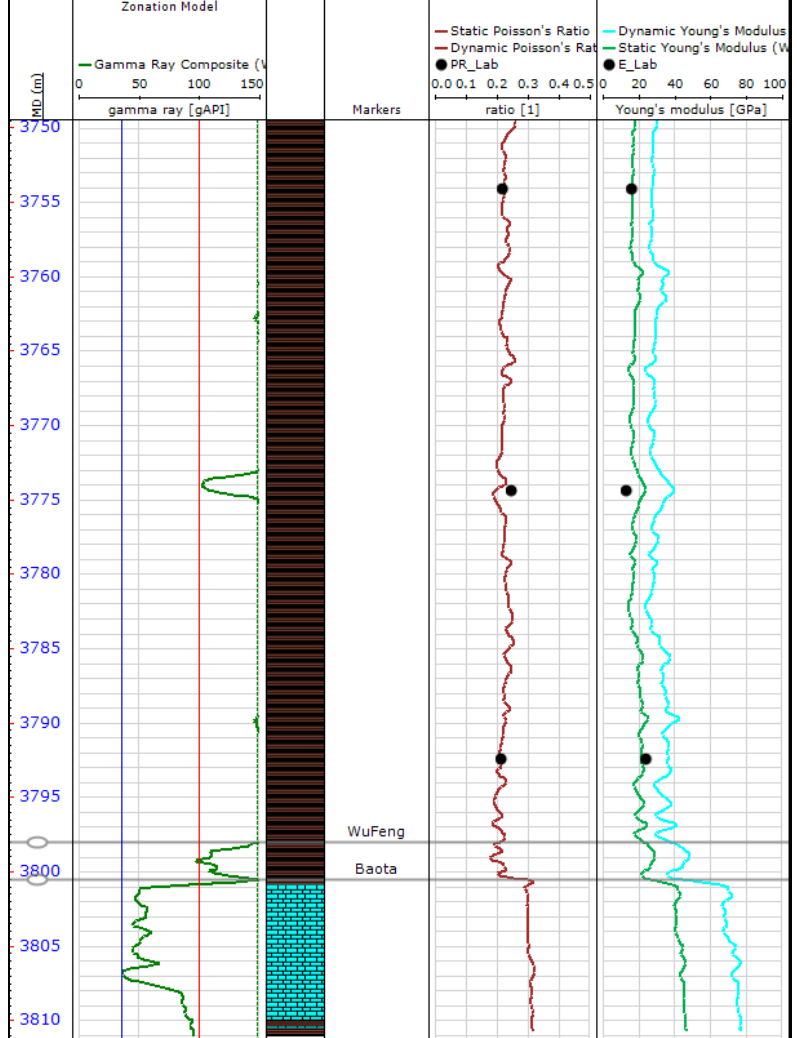
Figure 8. Rock mechanical properties calibration of W206.